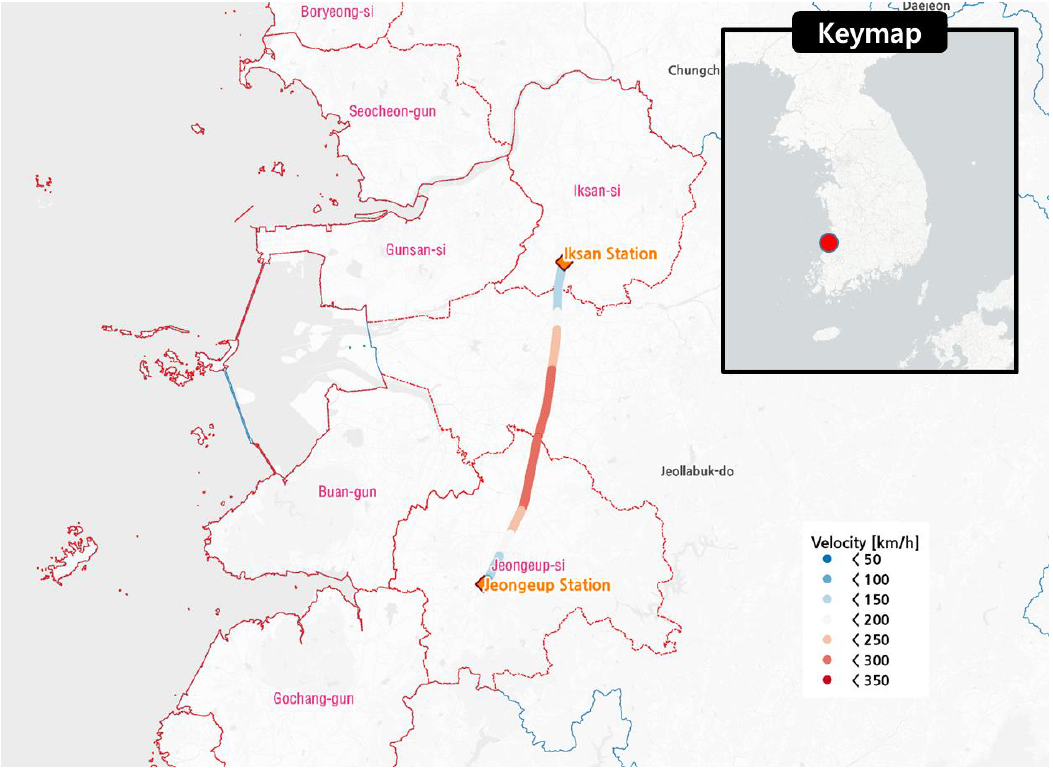
Figure 1. Travel route of the train for which train vibration data were collected.